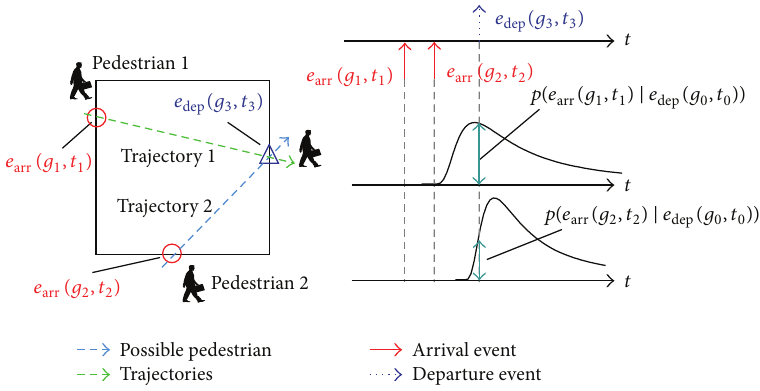
Figure 9: Example of pedestrian tracking in a